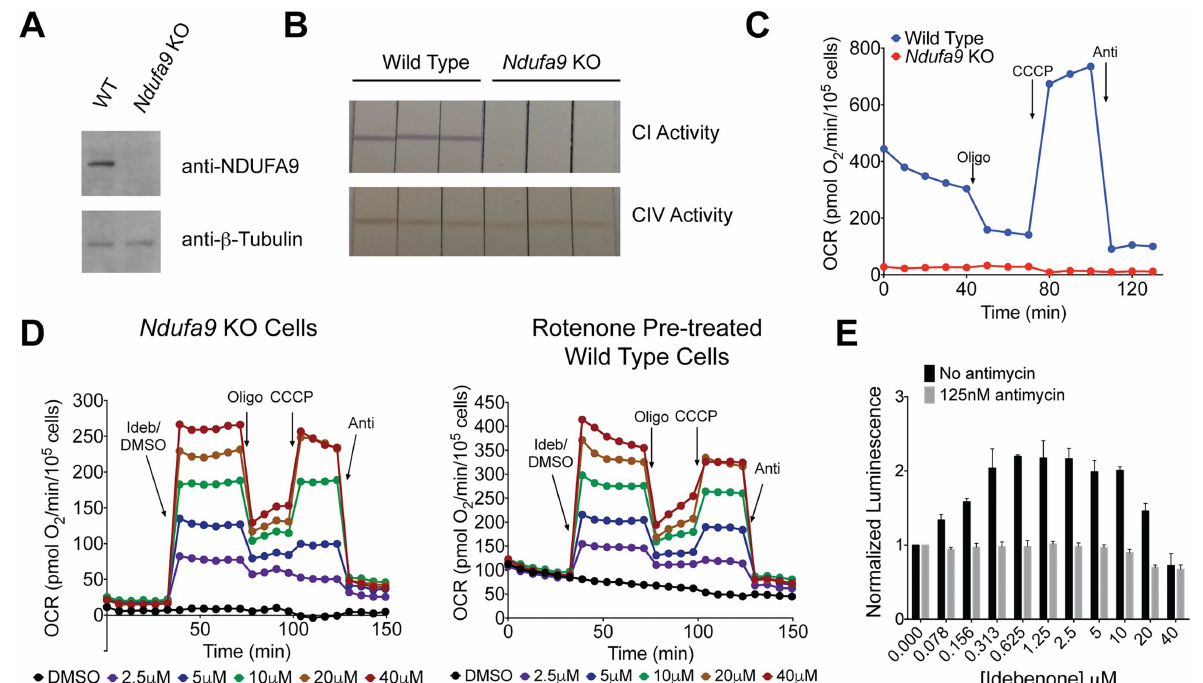
Fig 1. Validation of Complex I Deficient Cell Line and BypassScreeningAssay. (A) Westernblot of wild-typeand Ndufa9 knockout C2C12 cells. (B) Complex I and complex IV dipstick assays for wild-type and Ndufa9 knockout C2C12 cells, with technicaltriplicates shown for each. (C) Seahorse comparing wild-typeand Ndufa9 knockout C2C12 cells. (D) Seahorseof Ndufa9 knockout cells (left)and rotenone pre-treatedwild-typeC2C12s (right),each treatedwith a dose-response of idebenone. Doses are indicatedin the legend below each plot.(E) Luminescence-basedcomplex I bypass assay utilizing Ndufa9 knockout cells. Cells treatedwith a dose-response of idebenone in the presence or absence of 125 nM antimycin.For (A-D),each experimentwas performed threetimes, and a single representative experiment is shown. For (E) the data shown represent the average +/- SEM of data fromthreeindependent experiments.